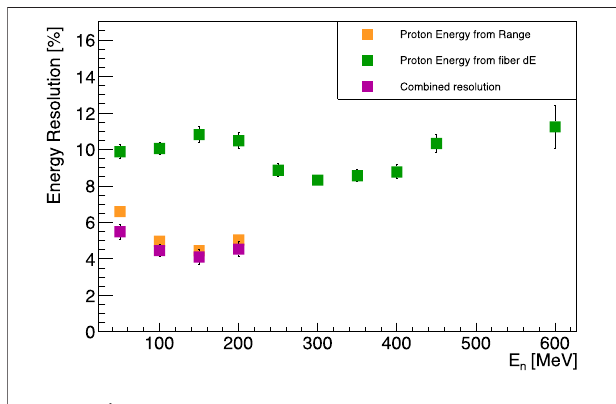
FIGURE 2 | Energy resolution for DES events as a function of the incoming neutron kinetic energy. Orange squares represent the energy resolution obtained via energy-range measurements while the green squares show resolution obtained from the dE / dx measurement. Violet squares represent the resolution obtained from the combination of the two